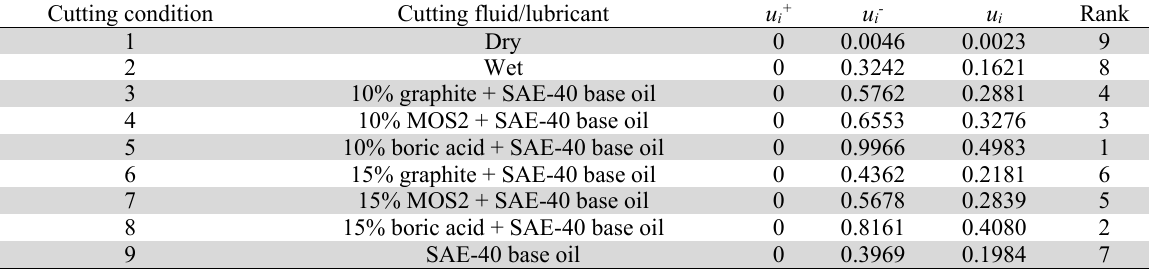
Computational details of the ROV method for case study 2 Cutting